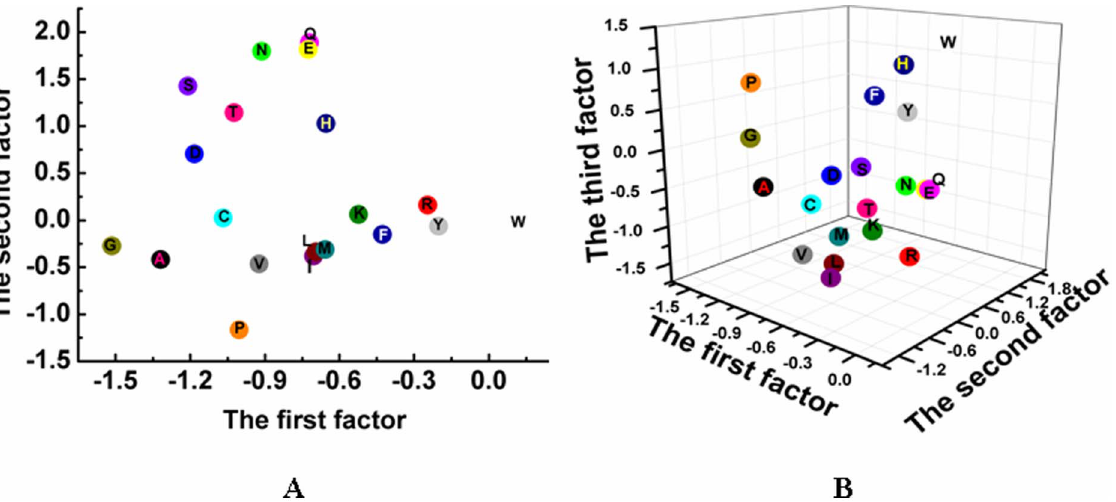
Figure 1. The 2- and 3-dimensional distribution of 22 natural amino acids on the first 2 and 3 factors. The A and B present the 2- and 3- dimensional distribution, respectively.